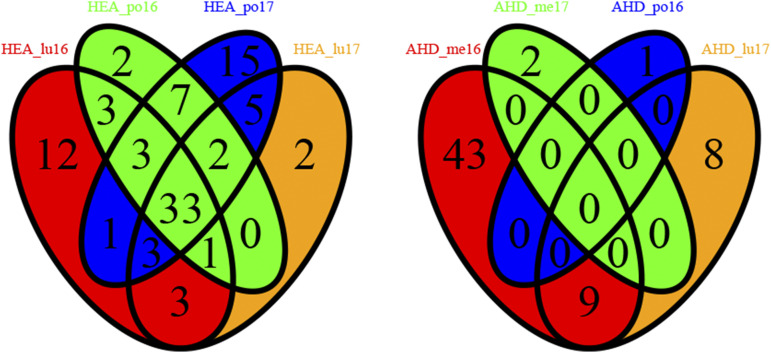
Venn diagrams displaying the number of significant SNP markers detected by GWAS (q-value < 10%) in different environments for a same trait, heading date (HEA) on the left and aftermath heading (AHD) on the right.